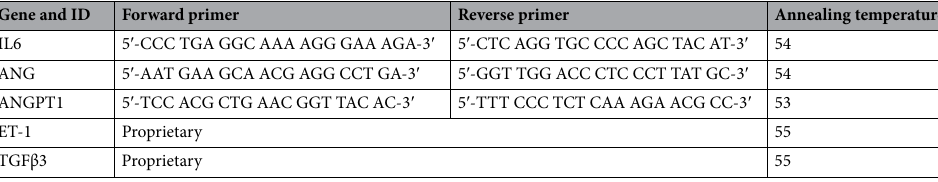
Table 2. Primer sequences for genes used in confirmatory